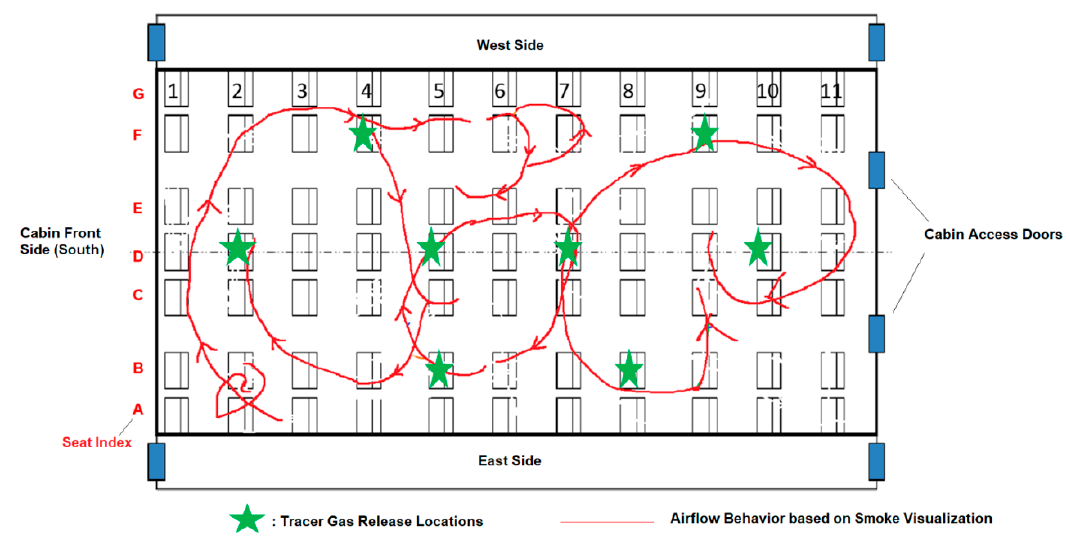
Figure 3. Airflow prediction based on smoke visualization testing [13] and tracer gas release locations used.